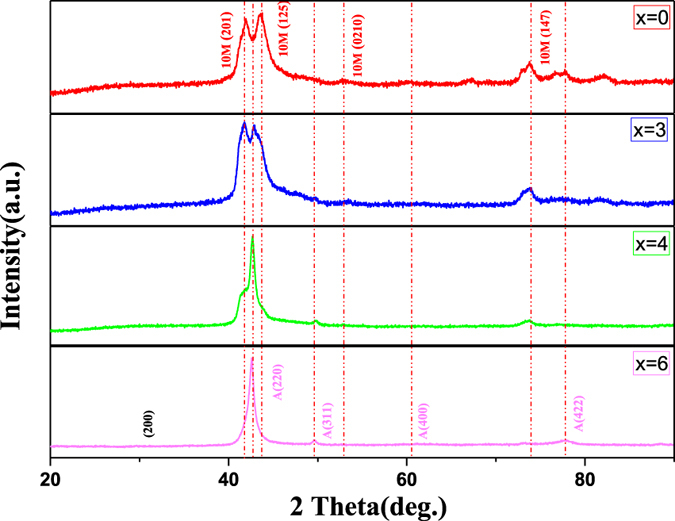
XRD of Ni50−xFexMn39Sn11 alloys at room temperature (a) x = 0; (b) x = 3; (c) x = 4; (d) x = 6.